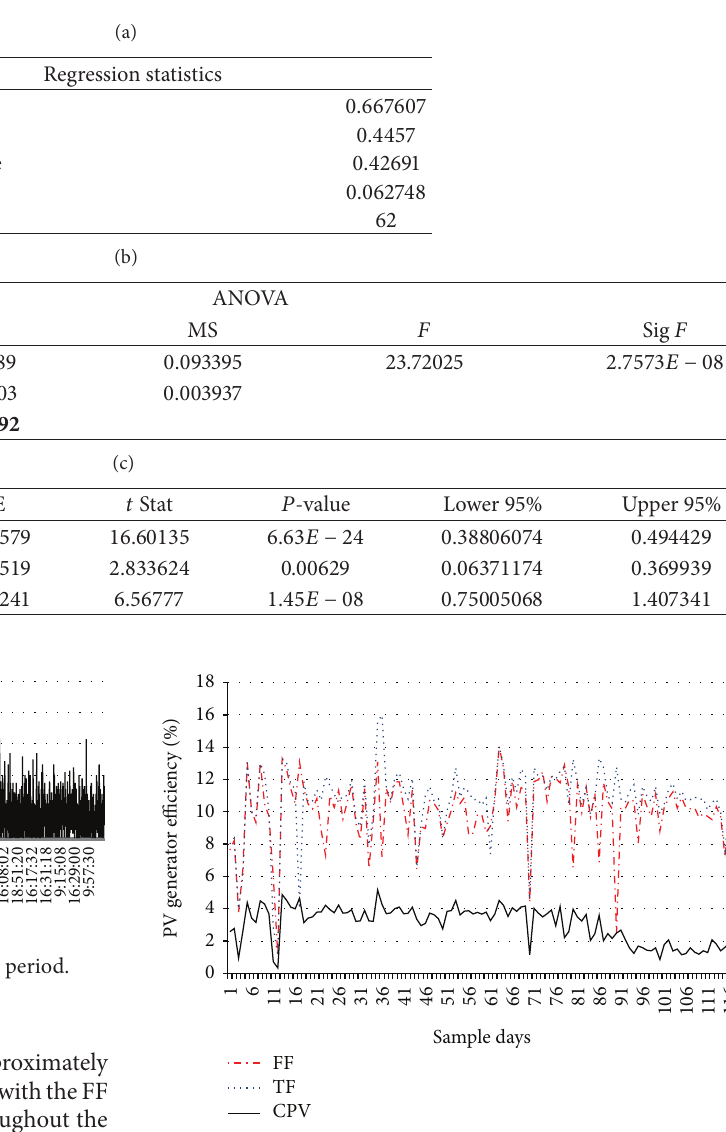
Figure 6: PV generator efficiency based on sampled field